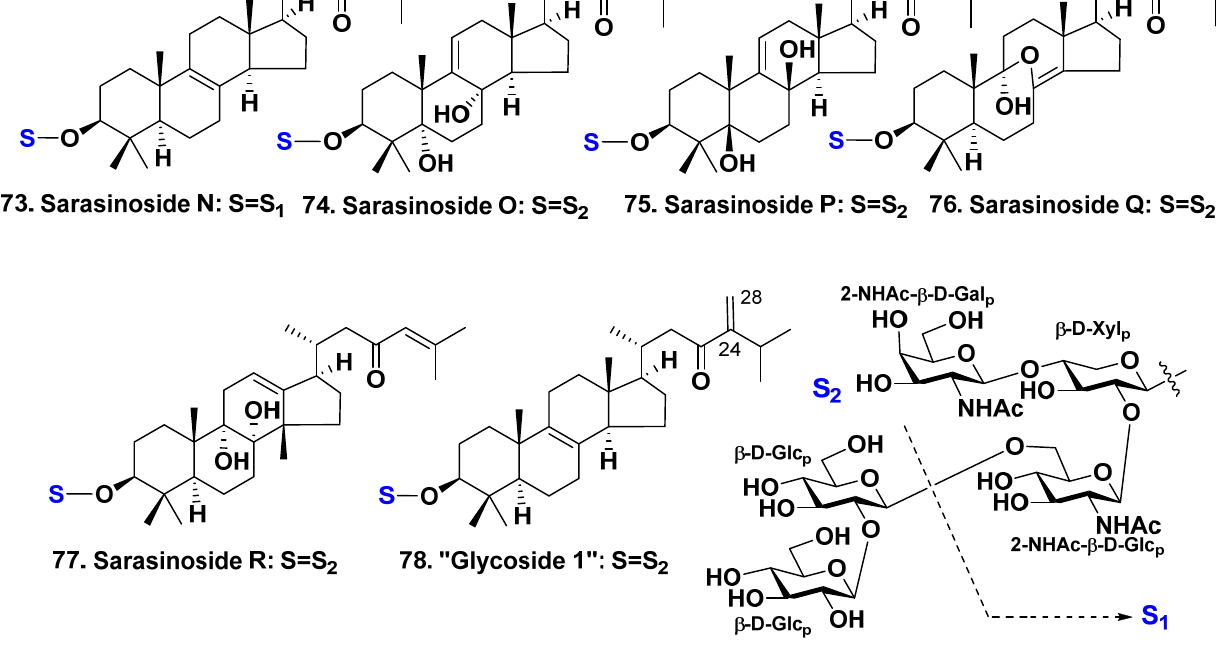
Figure 7. Structures of sarasinosides 73 – 77 and “glycoside 1” ( 78 ) from Lipastrotethya sp.